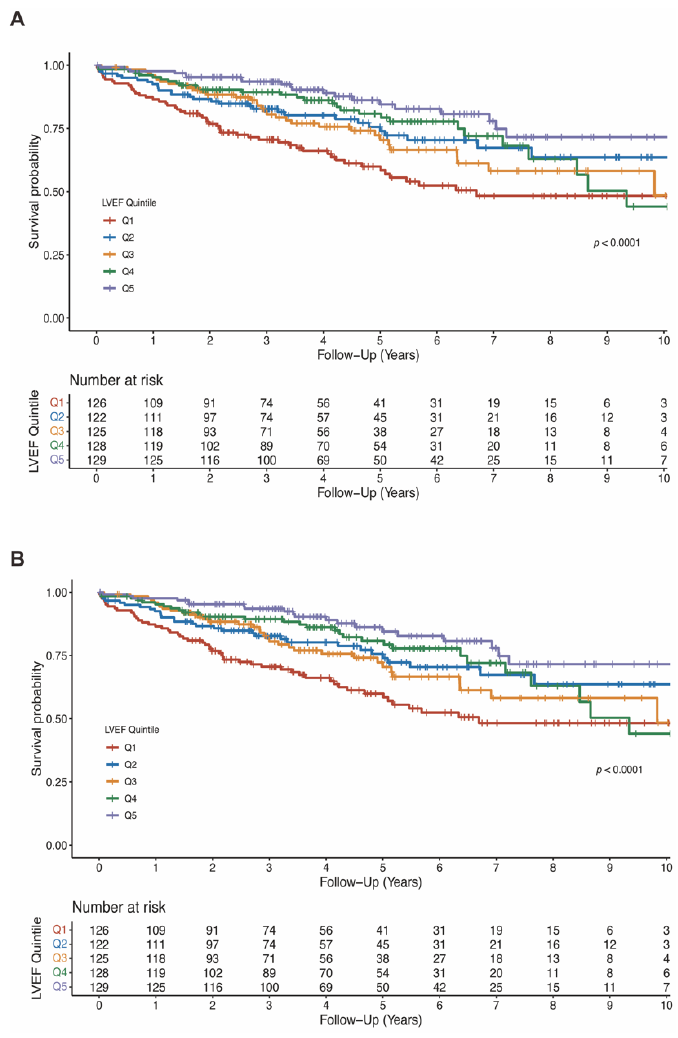
Figure 3. Kaplan-Meier estimates of survival according to LVEF quintiles ( A ) and LVEDD quintiles ( B ). LVEDD, left ventricular end-diastolic diameter; LVEF, left ventricular ejection fraction.